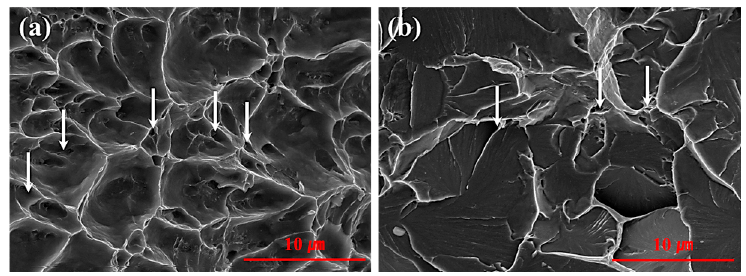
Figure 9. The fracture surface morphology of the specimens with different weld positions: ( a ) FGHAZ; and ( b ) IRCGHAZ.